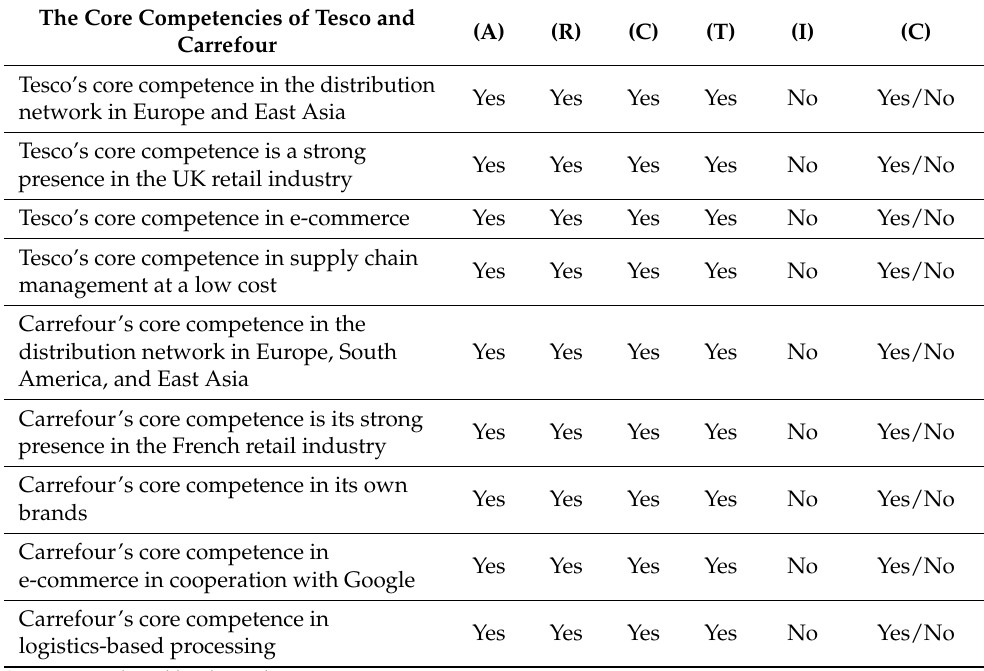
Table 6. The ARCTIC framework: analysis of complementarity, compatibility, and transferability of core competencies of the Tesco–Carrefour international alliance partners as prerequisites of explicit competence-based